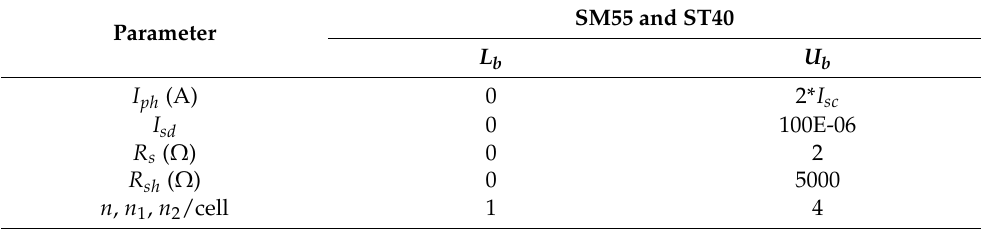
Table 4. Upper bound and lower bound for unknown parameters of both SM55 and ST40.